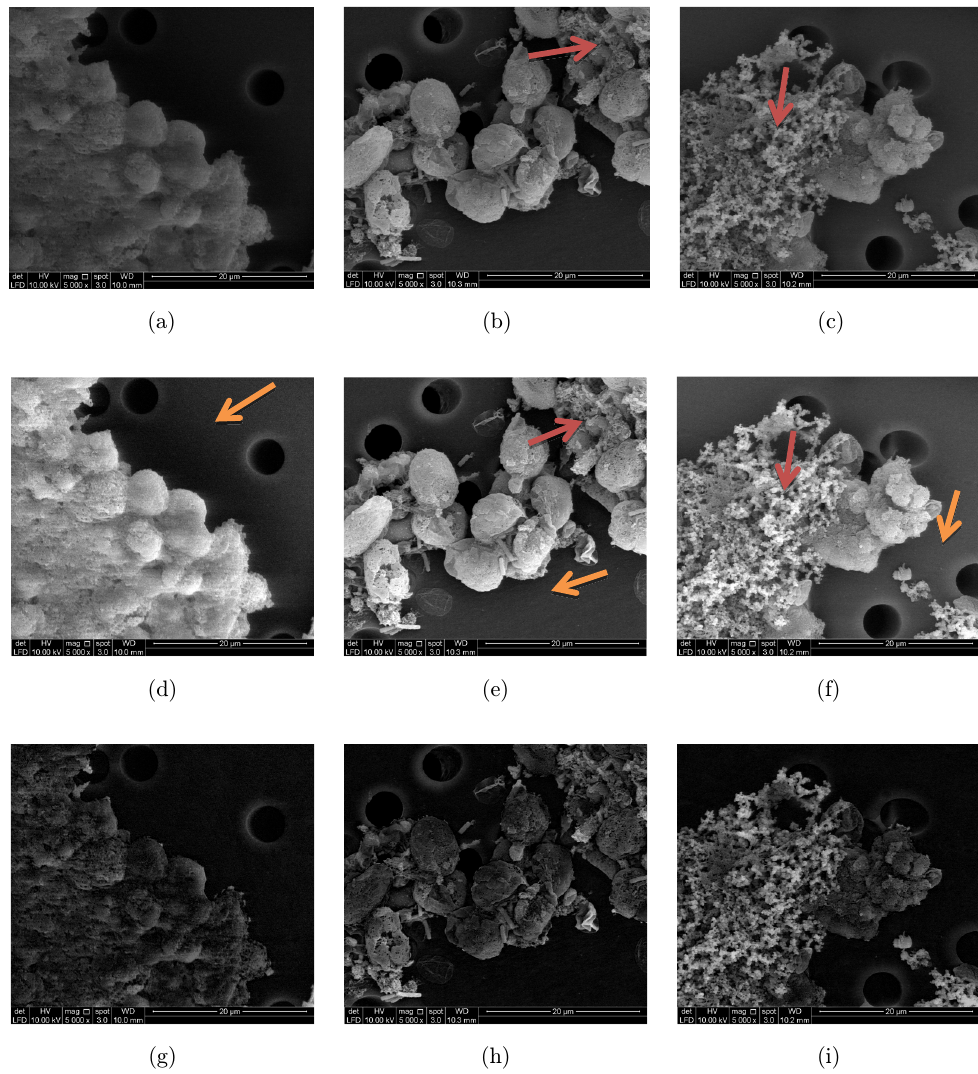
Fig. 5. (a) normal (o) (b) LSIL (o) (c) HSIL (o) (d) normal (cs) (e) LSIL (cs) (f) HSIL (cs) (g): normal (mo) (h): LSIL(mo) (i):